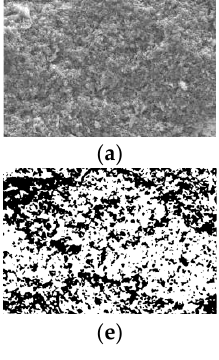
Figure 5. ( a ) SEM image of A1La5 processed at 1500 °C at scale: 50 μ m; ( b ) image converted to binary; ( c ) detected edges (Find Edges tool) giving an FD = 1.887; ( d ) detected edges (Canny Edge Detection plugin) giving an FD = 1.717; ( e ) image converted to binary with the median filter applied, ( f ) detected edges median filter applied, FE tool, FD = 1.751; ( g ) detected edges, median filter applied, CED plugin, FD =